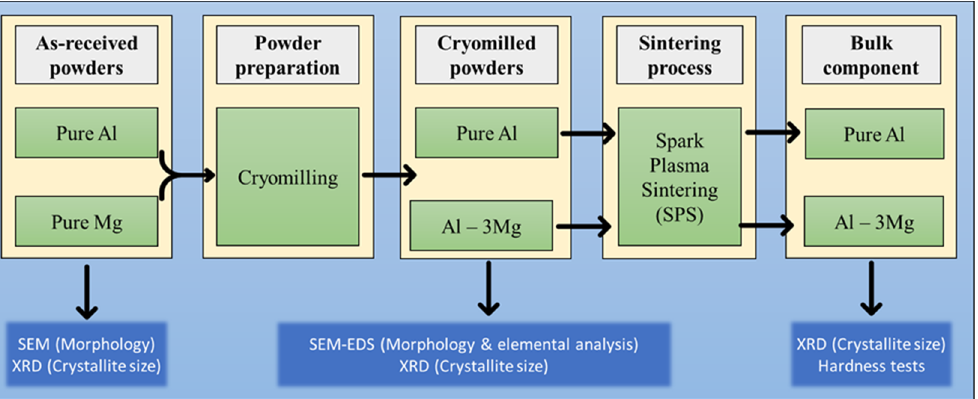
Figure 1. Process flow diagram for the manufacturing of bulk components using cryomilling and SPS.